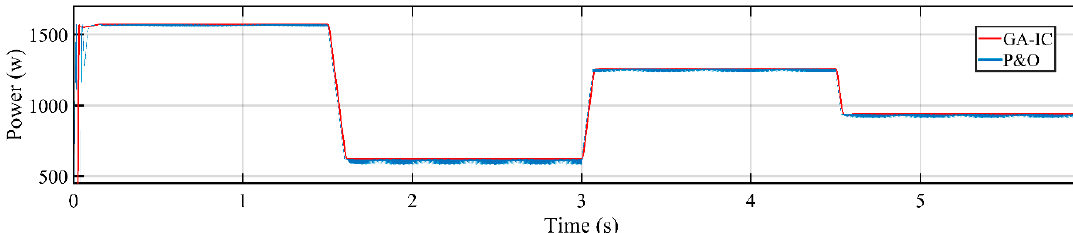
Figure 16. Case 1 power comparison of modified GA-IC vs. P&O.